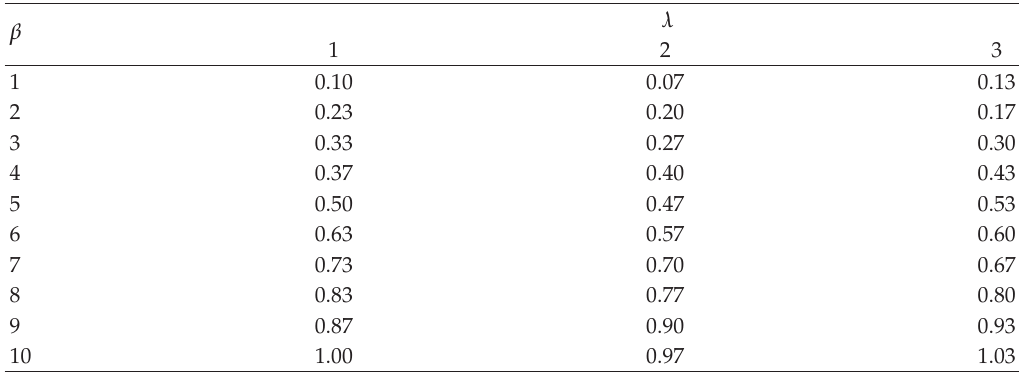
Table 6: The summary of parameter θ βλ .